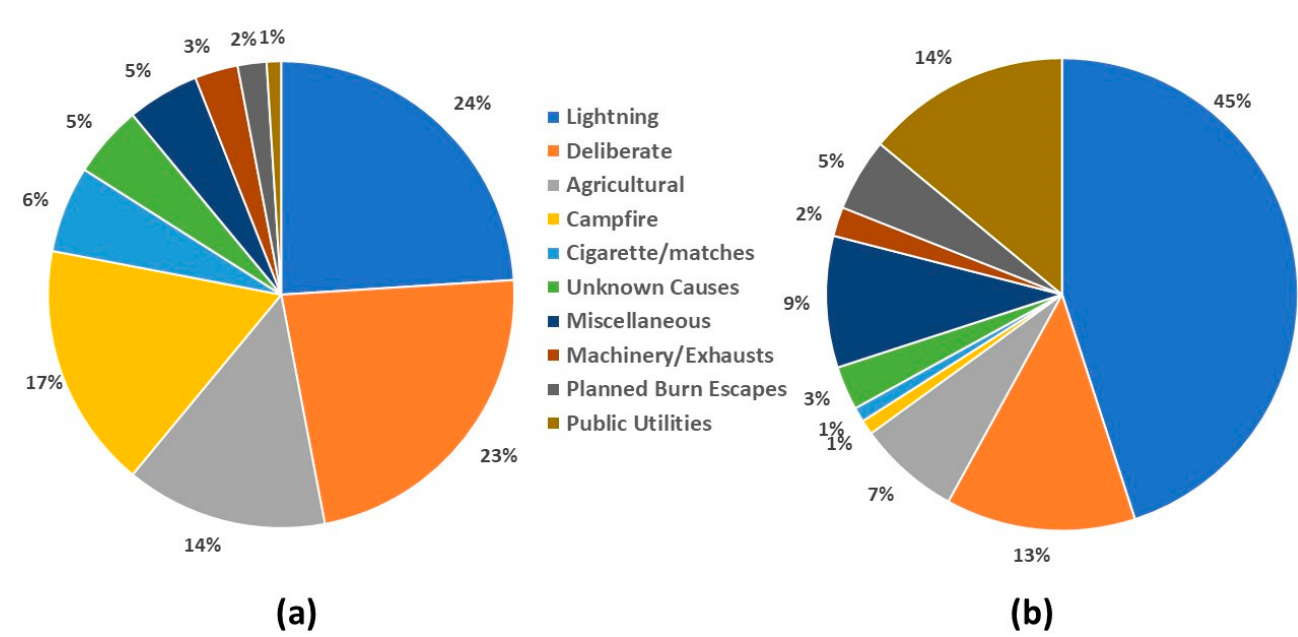
Figure 1. Bushfires in the past two decades ( a ) Casuse frequency of bushfire events and ( b ) Contribution of sources of bushfires to the burnt areas.